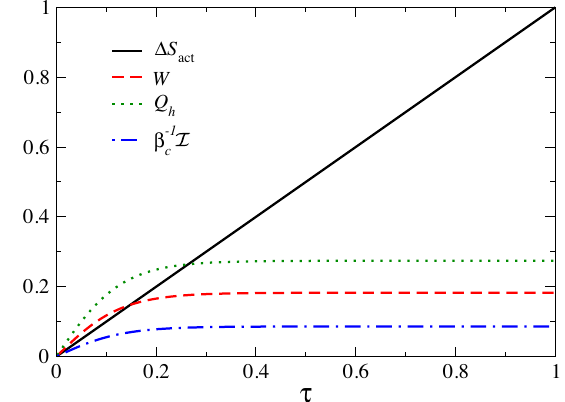
FIG. 3. The different scaling with τ of Δ S W , Q I for an active heat engine with fixed Δ μ . The h , and ≥ I holds true for any value of τ . The parameters inequality Δ S act are set to β c ¼ 1 , β h ¼ 0 . 1 , E ¼ 0 . 5 , δ E ¼ 1 , k ¼ 10 , and Δ μ ¼ 2